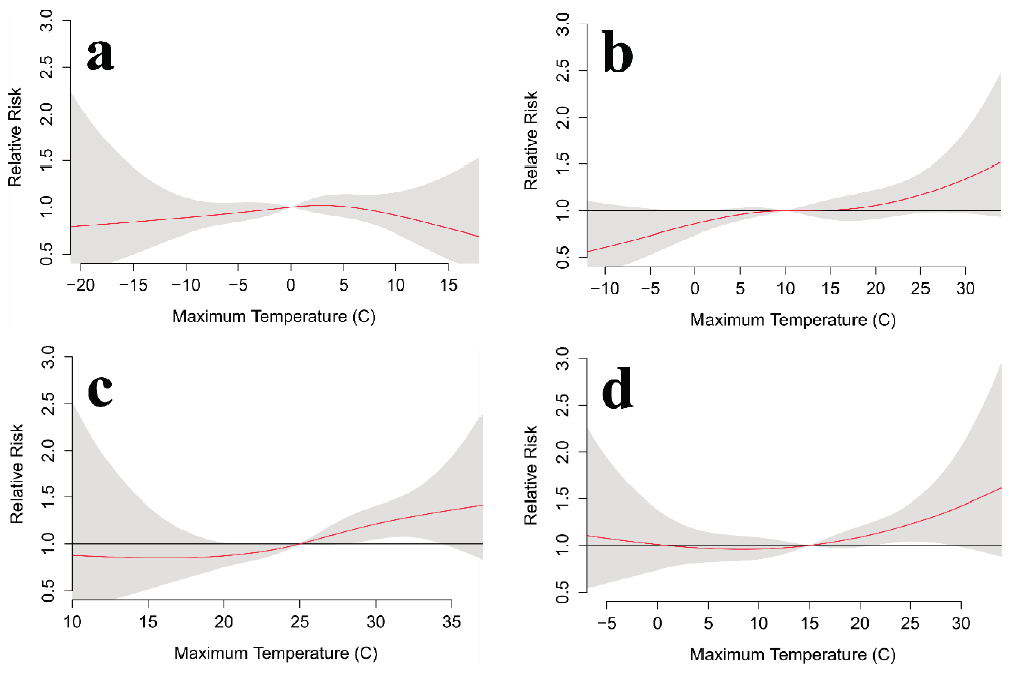
Figure 9. Toronto relative risk for suicide at various daily maximum temperatures over a 6-day lag for ( a ) winter, ( b ) spring, ( c ) summer, and ( d ) fall. The red line is the predicted value and the gray shading represents the 95% confidence interval.